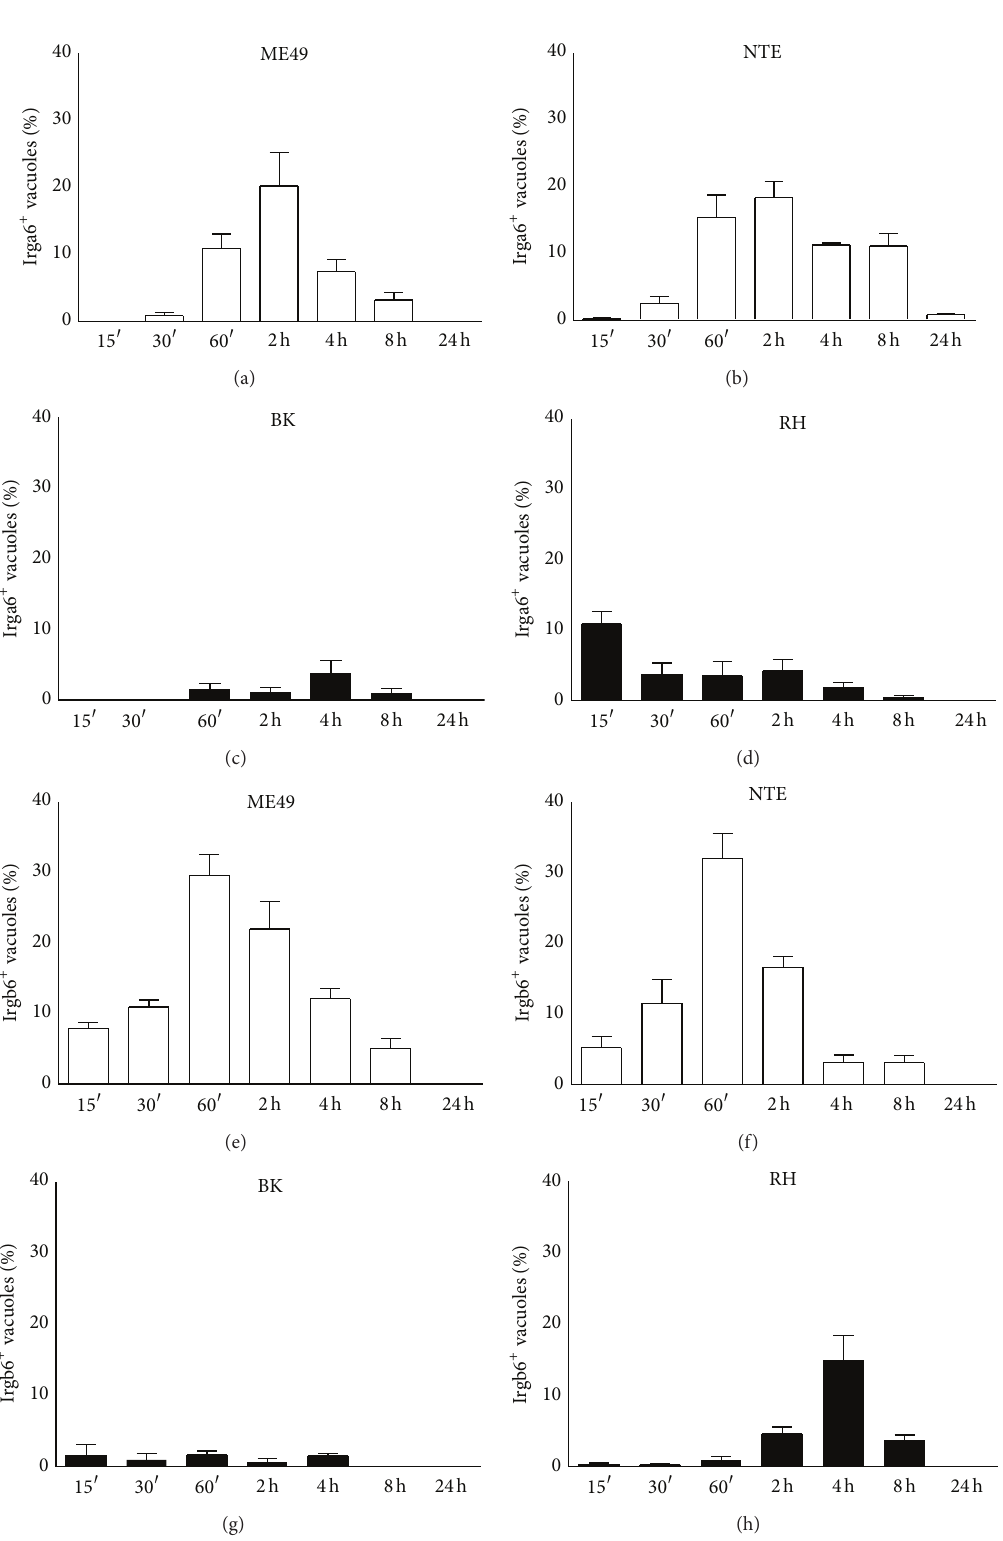
Figure 2: Accumulation of Irga6 and Irgb6 at the PV of different T. gondii strains in astrocytes. Astrocytes were prestimulated with 100U/mL IFN 𝛾 , pulse-infected with different T. gondii strains (MOI: 10) for the indicated time points, and stained for Irga6 ((a)–(d)) and Irgb6 ((e)– (h)). PVs were identified via nucleus staining of tachyzoites with DAPI. ((a)–(d)) Counted Irga6 + vacuoles were expressed as percent of all PVs. (a): ME49; (b): NTE; (c): BK; (d): RH. ((e)–(h)) Counted Irgb6 + vacuoles were expressed as percent of all PVs. (e): ME49; (f): NTE; (g): BK; (h): RH. The data represent means of five independent infection experiments in